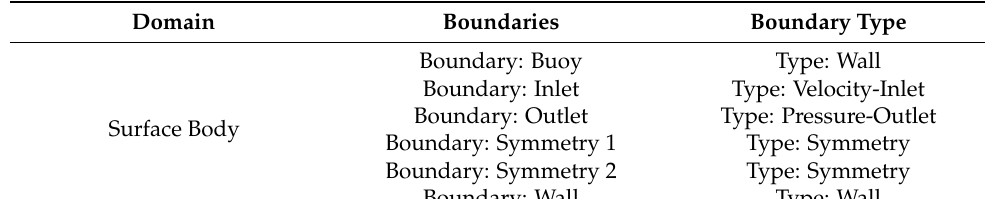
Table 5. Boundary physics showing boundaries and domain of the buoy in CFD.